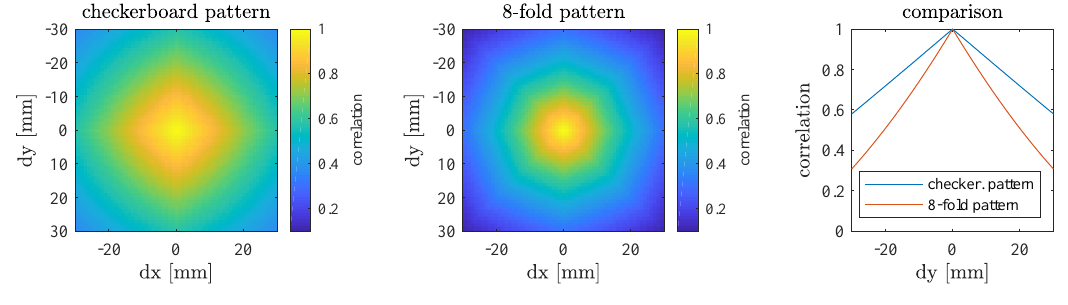
Figure 12. Left and middle : simulated correlation functions depending on the shift [ dx , dy ] for a checkerboard pattern and for an 8-fold pattern, right : direct comparison between the two simulated correlation functions depending on the shift dy